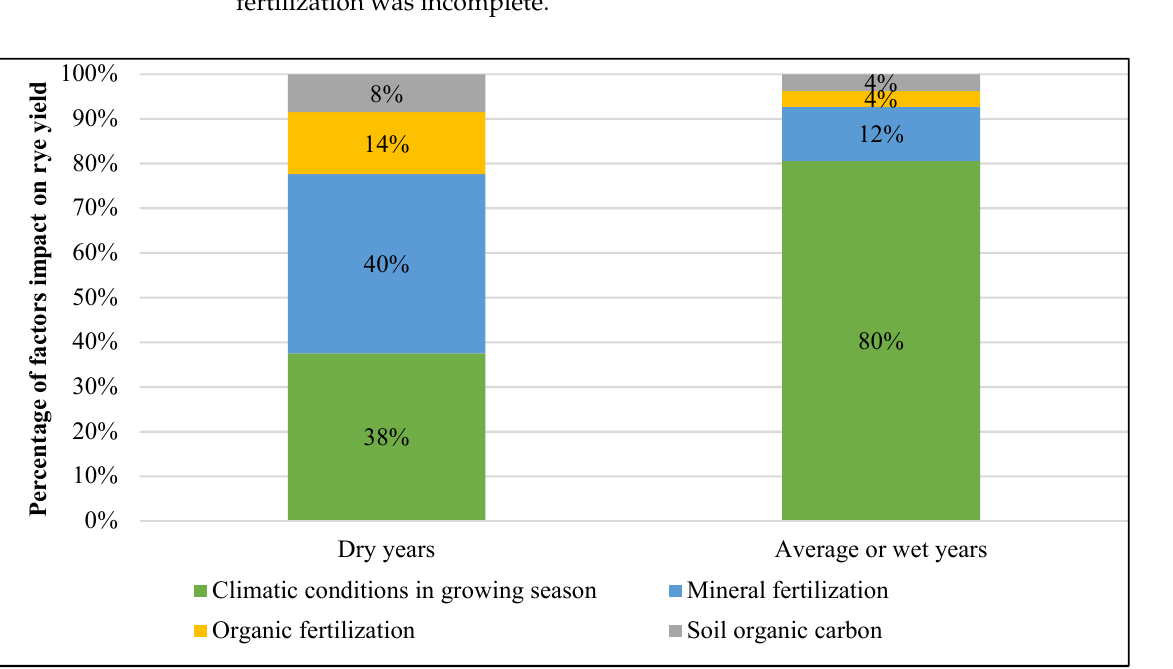
Figure 4. Percentage of factors impact on the grain yield of winter rye in dry years (left bar) and average or wet years (right bar) (Skierniewice LTE 1966–2015), obtained used variance components from a linear mixed model. Definition of dry years: CWB from May to June ≤100 mm (n = 27); Definition of average or wet years: CWB from May to June >100 mm (n = 22); All values are significant for p < 0.05. See specific CWB values (1966–2015) in Figure A1 (Appendix).